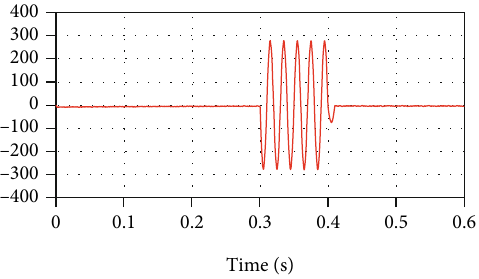
Figure 5: Compensation voltage v